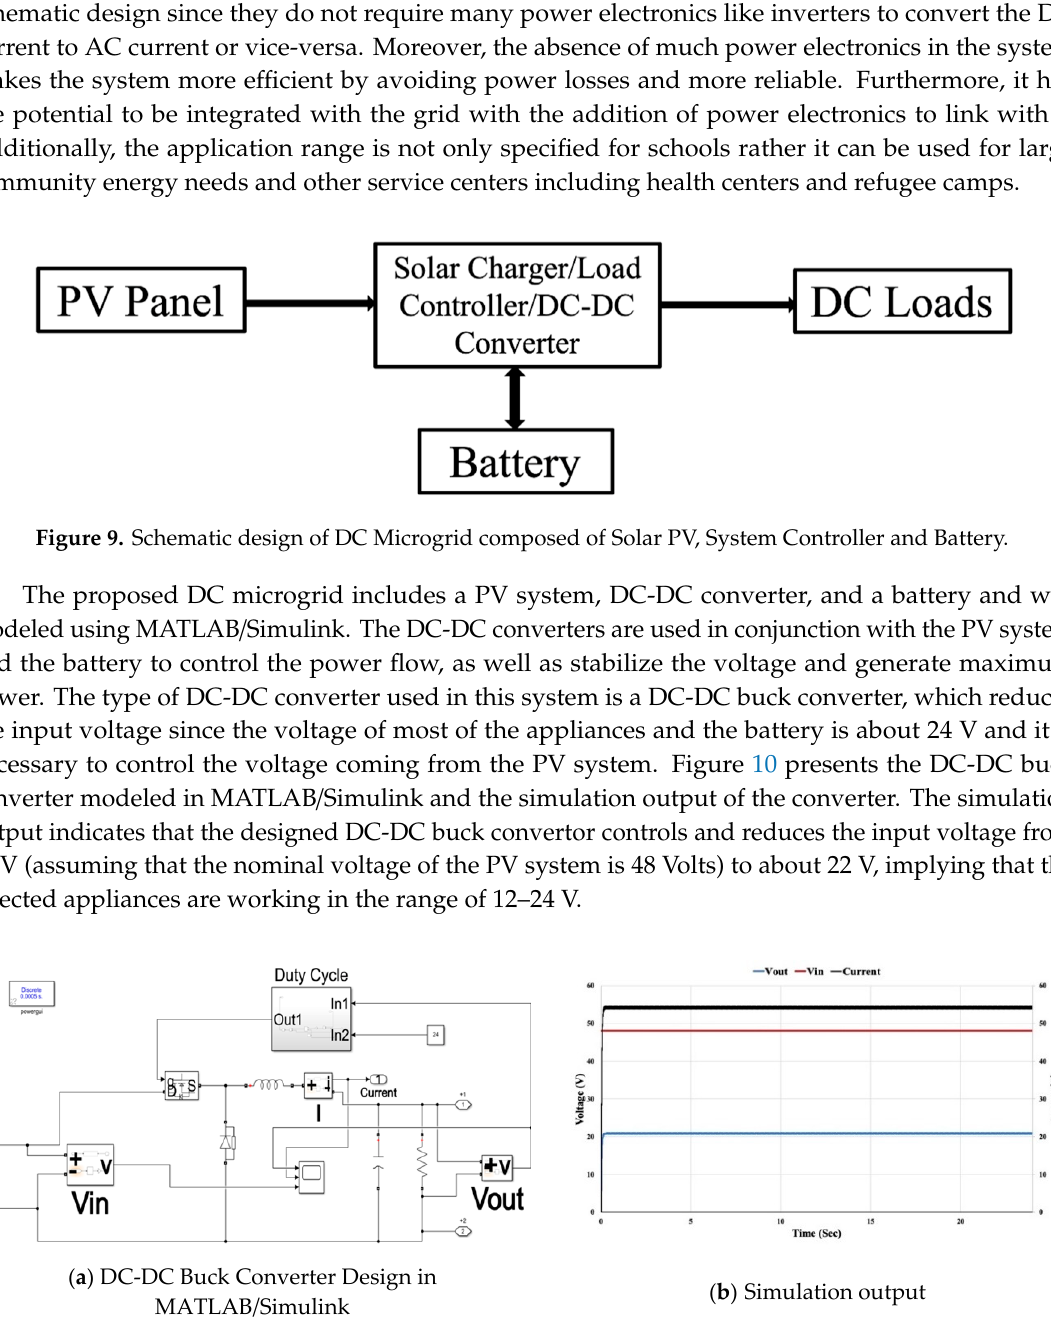
Figure 10. Design and simulation output of DC-DC buck converter design in MATLAB/Simulink: ( a ) DC-DC buck converter design; ( b ) simulation output.